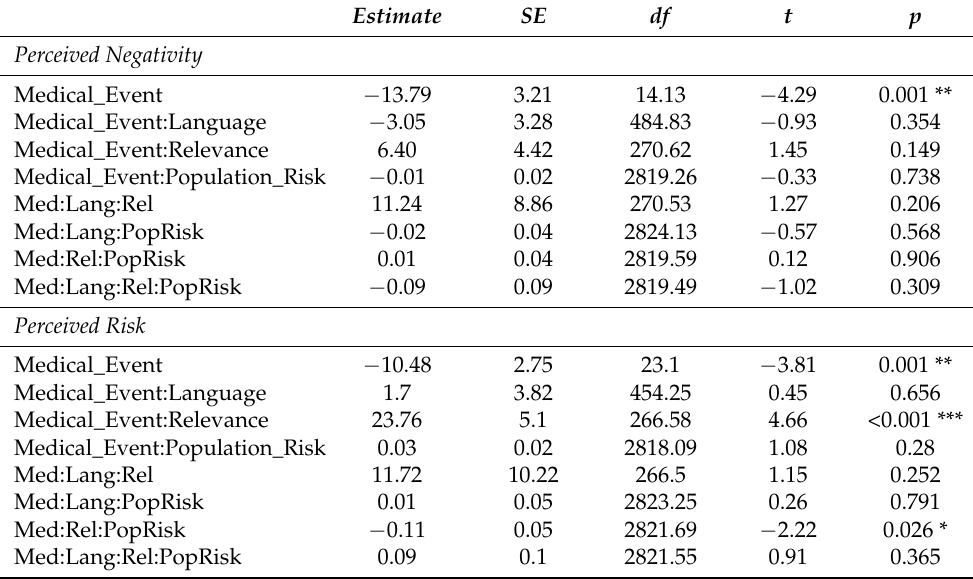
Table A1. Effects of Medical Event on Perceived Negativity and Perceived